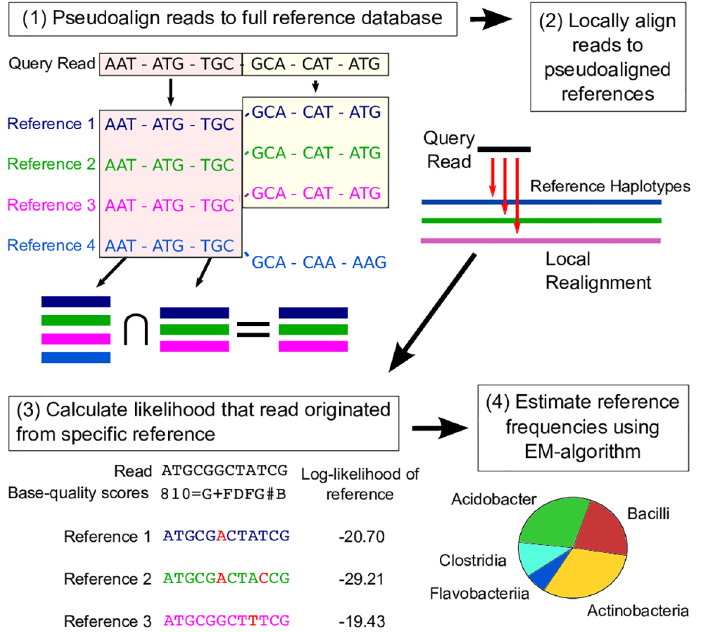
Fig 1. Overview of Karp. (1) Query reads are pseudoaligned against an index of the reference database, resulting in a set of references they could have potentially originated from. (2) The query reads are locally aligned to the possible references. (3) Using the best alignment, the likelihood that a read originated from a specific reference is calculated. (4) Using the read likelihoods an EM-algorithm is employed to estimate the relative abundances of the references in the pool of query reads.